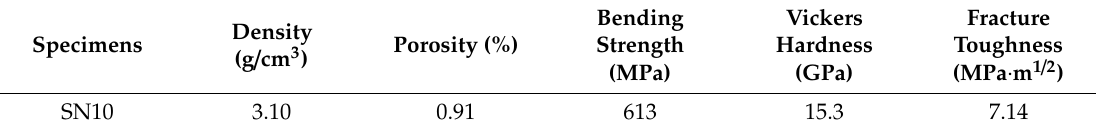
Figure 1. XRD analysis result of the SN10 ceramic. Table 1. Physical and mechanical properties of the SN10 composite.